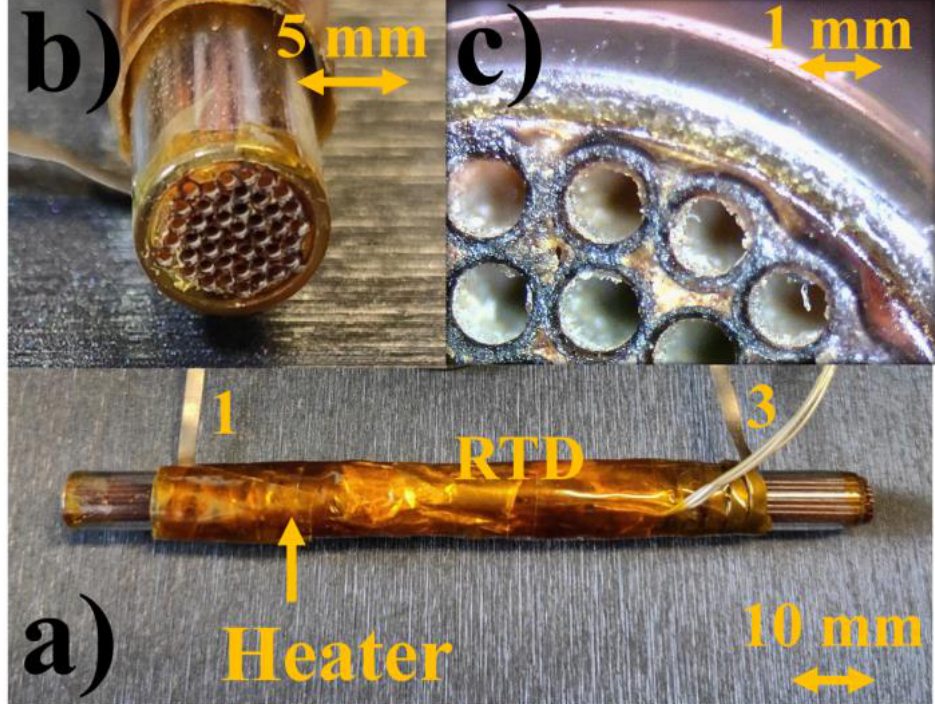
Figure 4. ( a ) Prototype of the Packed Columns Cartridge (PCC) with a rolled-up heater element and Resistance Temperature Detector (RTD). The final total PCC length was 80 mm. In particular, (1) and (3) wires were the heater extremities. ( b ) An extremity of the PCC and ( c ) a detail of the PCC segment column extremities.